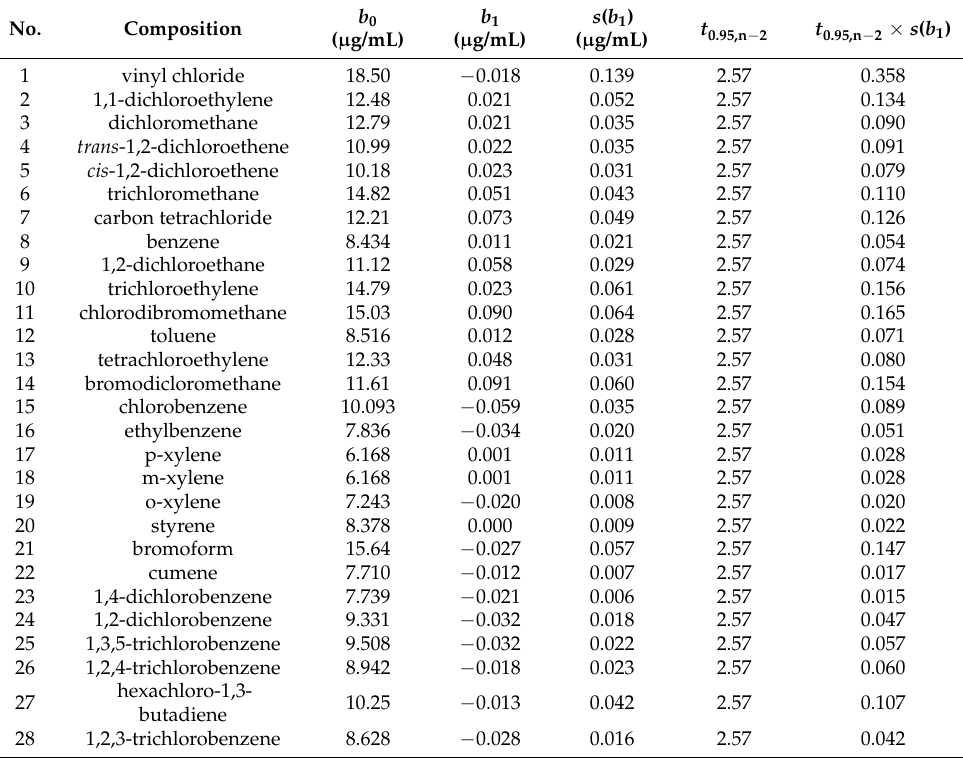
Table 4. Stability study for VOCs spiking solution stored at − 18 ◦